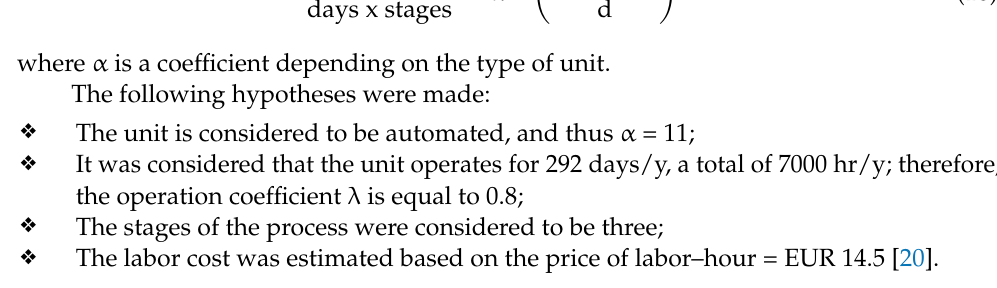
Table 3. Reactions used in simulation with Aspen Plus.